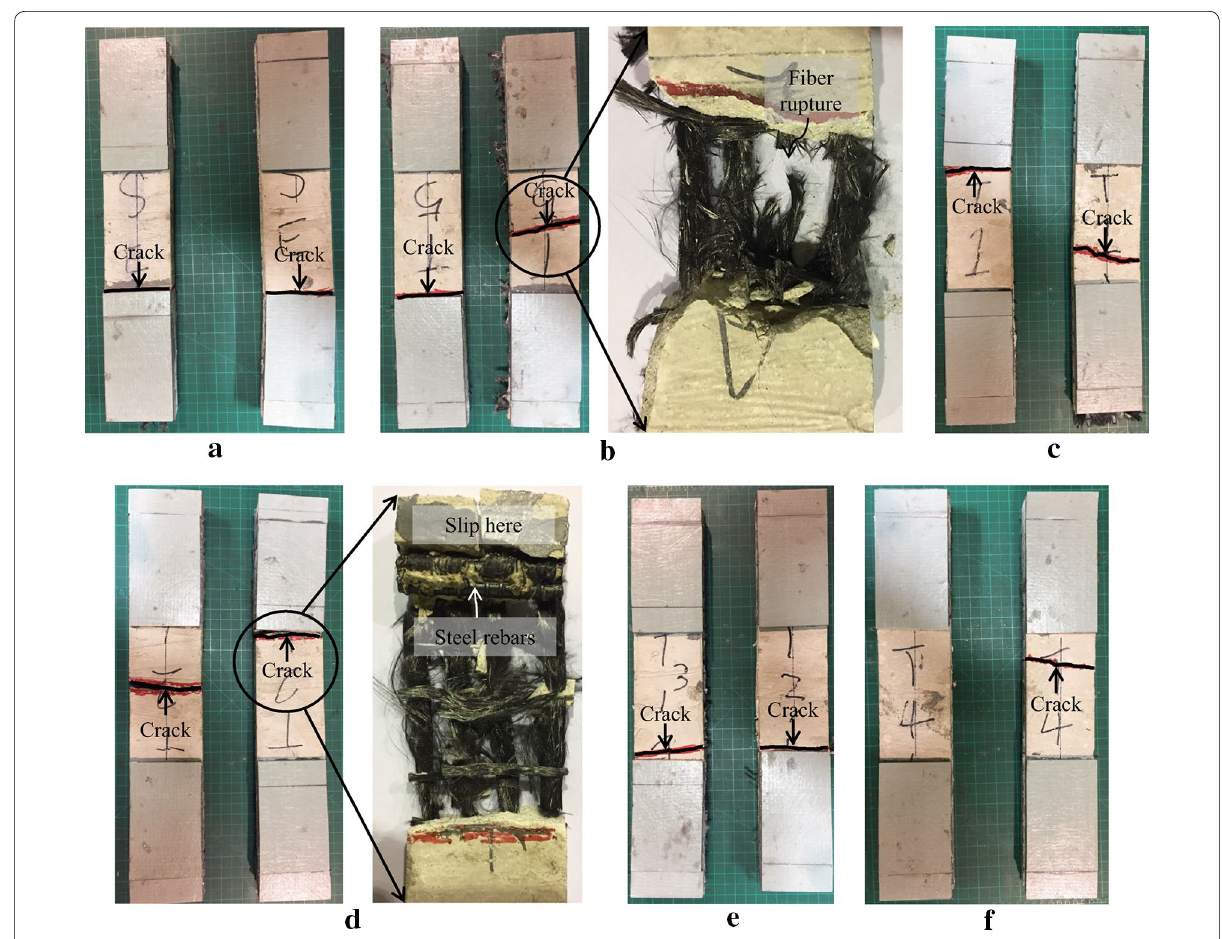
Fig. 6 Failure mode of TRM test specimens in this study. a BASE, b SPREAD, c TAB, d REBAR, e L_COAT, f